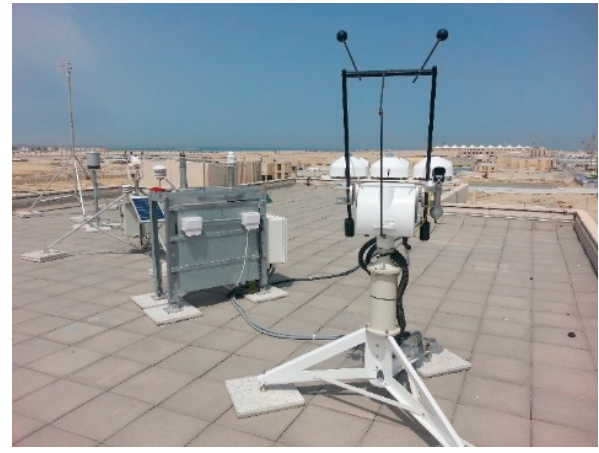
Figure 2. Solar monitoring station on the roof of the College of Architecture and Planning, Imam